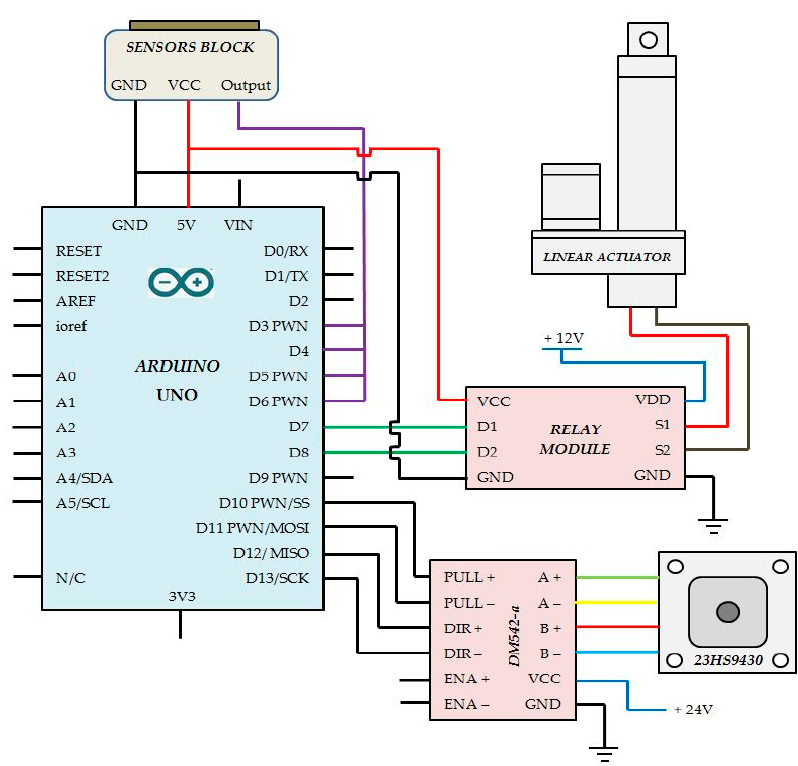
Figure 8. Real scheme of wiring of the prototype’s elements.